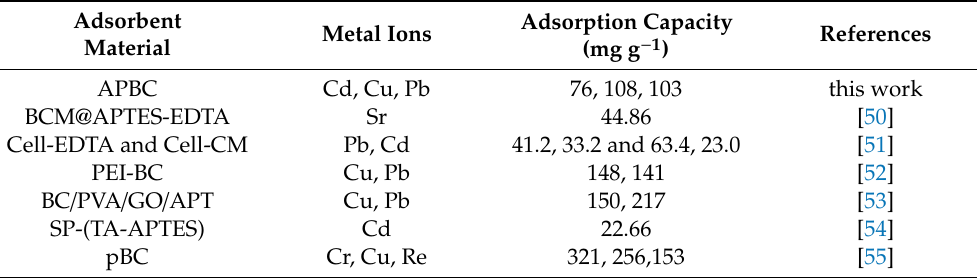
Table 8. Metal ions adsorption onto di ff erent cellulose fibers-based adsorbents.